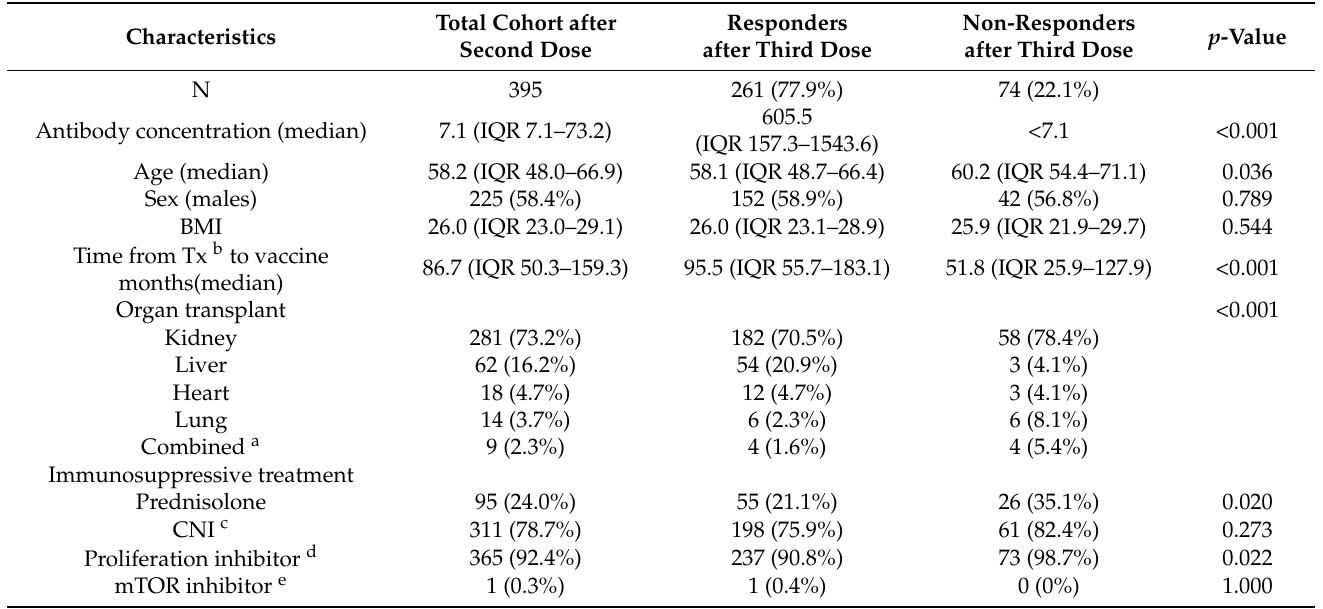
Table 1. Characteristics of solid organ transplant recipients who completed the third dose of a SARS-CoV-2 mRNA